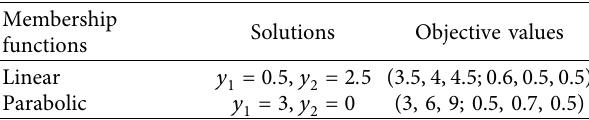
Table 4: Results of diet problem.